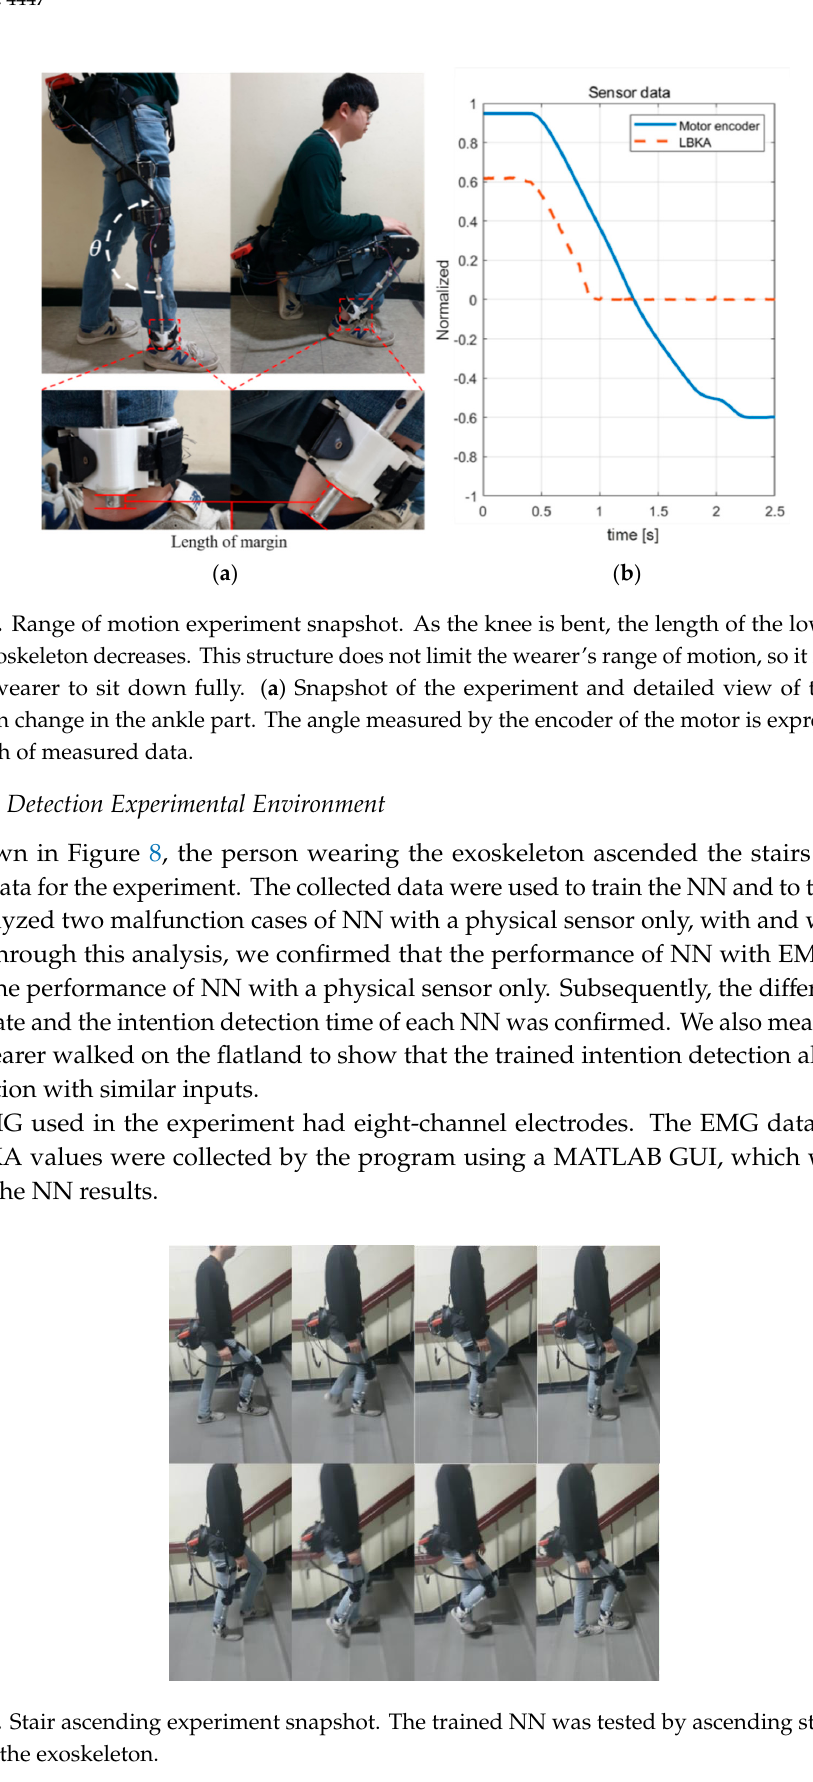
Figure 8. Stair ascending experiment snapshot. The trained NN was tested by ascending stairs while wearing the exoskeleton.